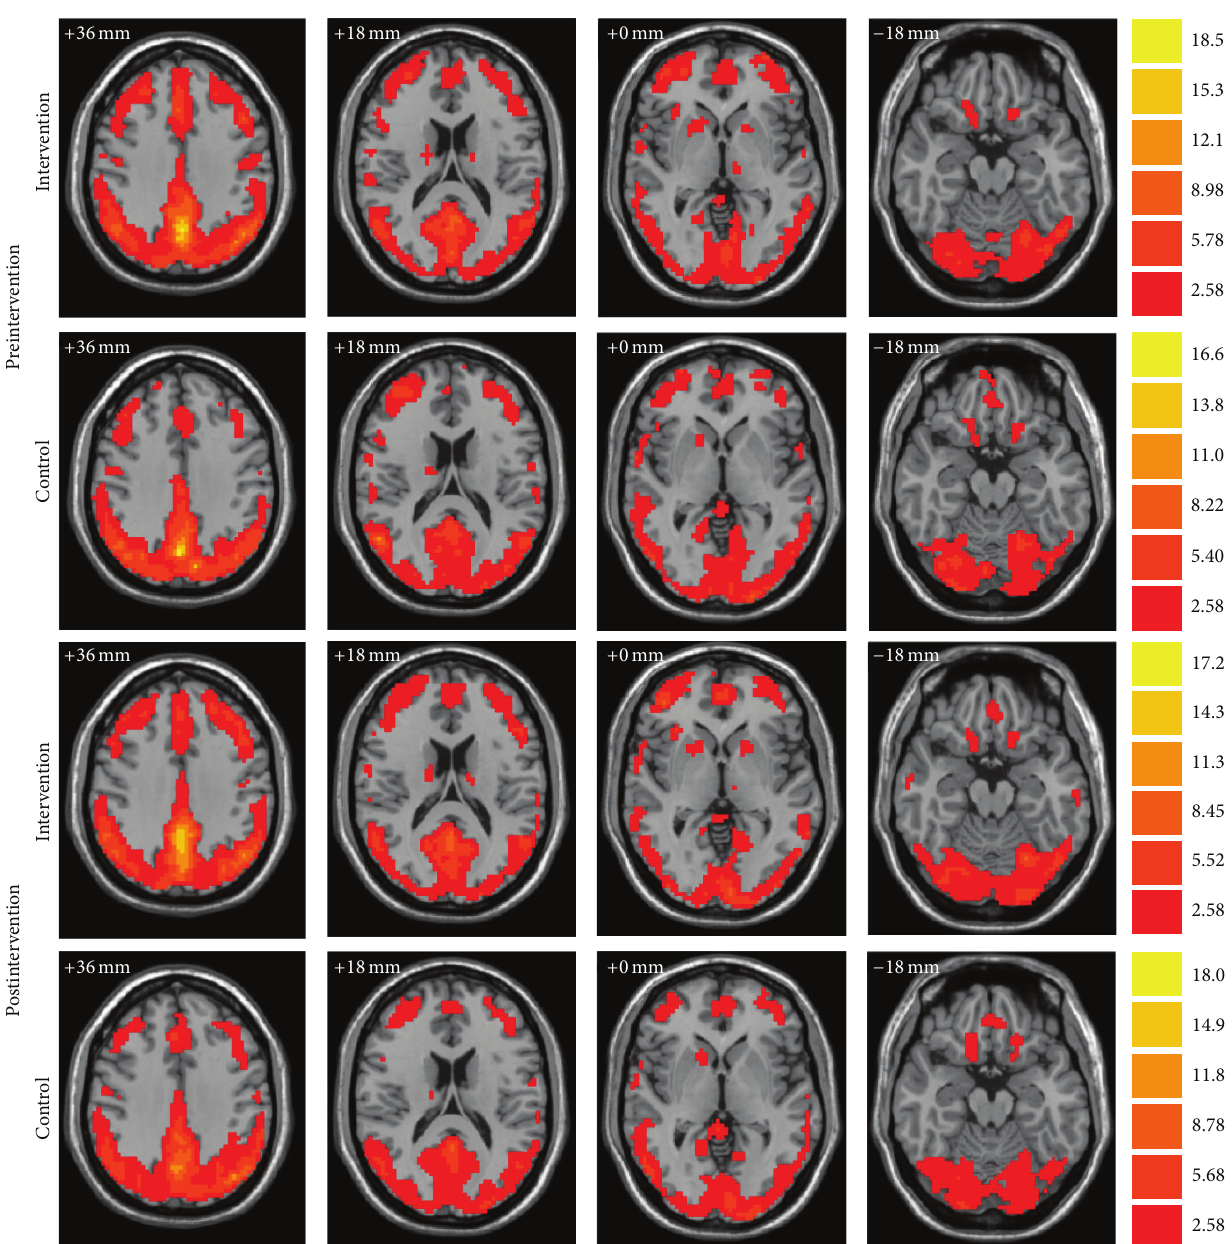
Figure 2: Whole-brain analyses of ReHo are visualized, respectively, for intervention and control groups both before and after intervention. Bars at the right show t -values. Following radiological convention, the left side of the image corresponds to the right side of the subject.